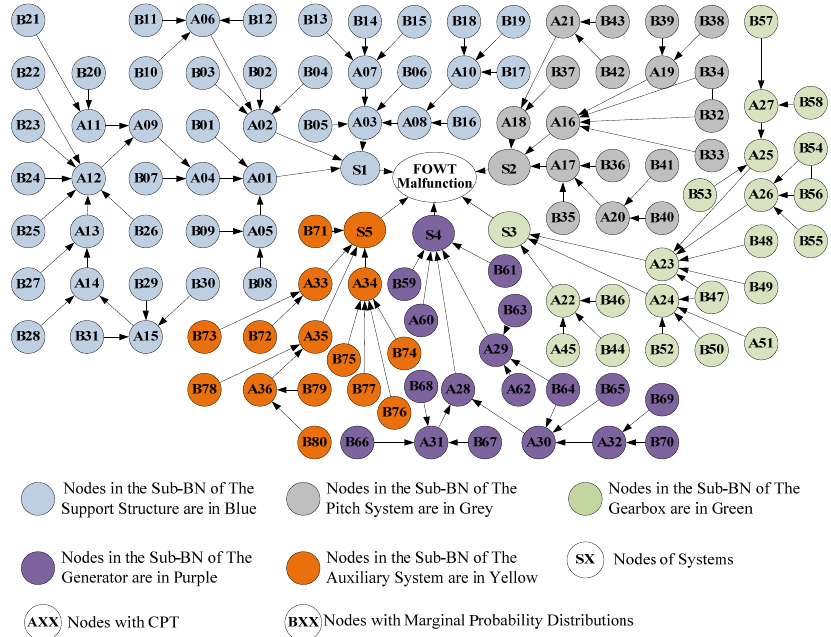
Figure 15. The BN model of the floating offshore wind turbine [18,33] (see Appendix D).